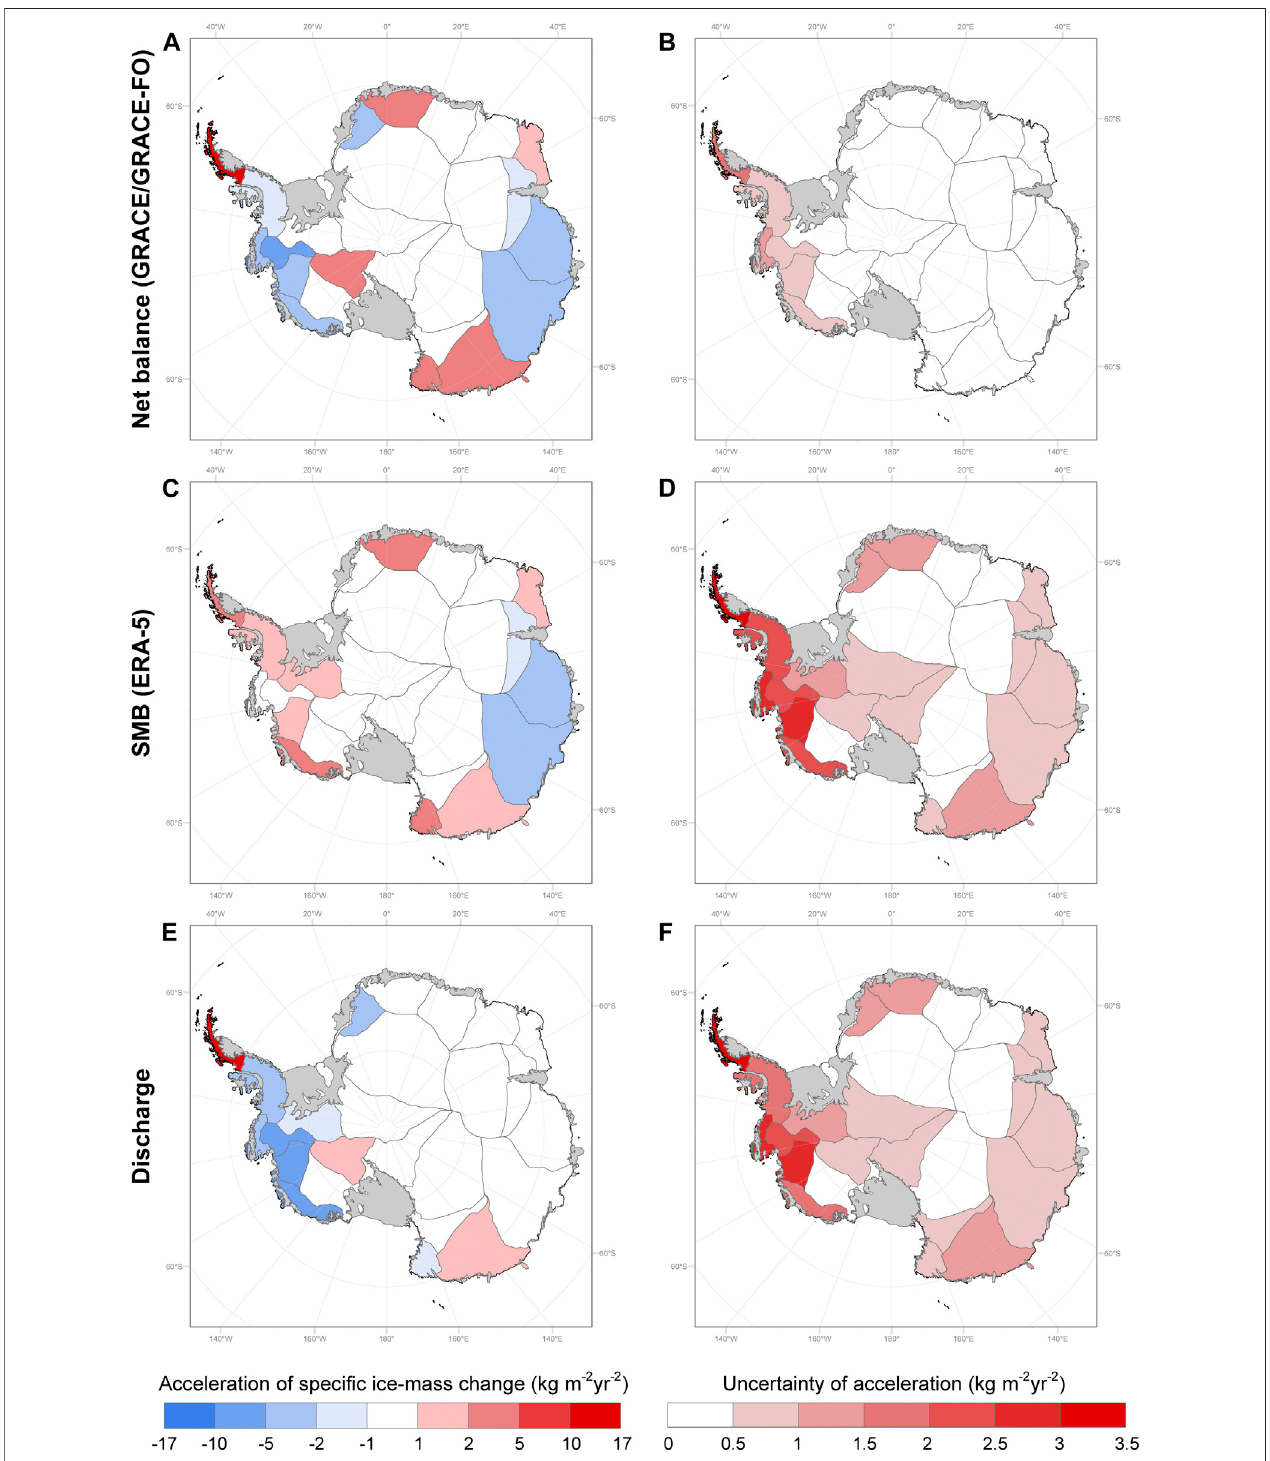
FIGURE 4 | Acceleration of mass change and its components for 25 drainage basins in Antarctica between 2002 and 2020. Shown are the accelerations of (A) € masschange € M (GRACE/GRACEFO), (C) thecumulativesurfacemassbalance, SMB (ERA-5)and (E) cumulativeice-dynamicdischarge, € D (indirectmethod),basedon the difference between GRACE/GRACE-FO and the SMB component, along with their respective 1- σ uncertainties in (B,D,F) . Acceleration (blue) and deceleration (red) causedbyarespectivemassloss increaseandmassgainincreasearerepresentedaschangeofspeci fi cmassbalance(kgm − 2 yr − 2 ).Thetimeperiod isApril2002 toSeptember2020.Accelerationsanddecelerationsaredenotedaccordingto Eq.2 (factor½).Notethatanon-linearcolorbarischosenin (A,C,E) toemphasizesignals of smaller magnitude. Results of the t- Test for signi fi cance are indicated in Supplementary Table S1 . The projection is Polar Stereographic centered at 90 ° S and 0 ° E, with the true latitude of 71 ° S and WGS84 (EPSG:3031).